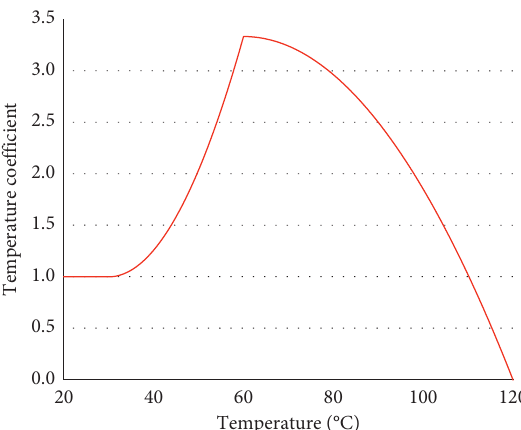
Figure 4: Impact of temperature on evacuation coefficient.